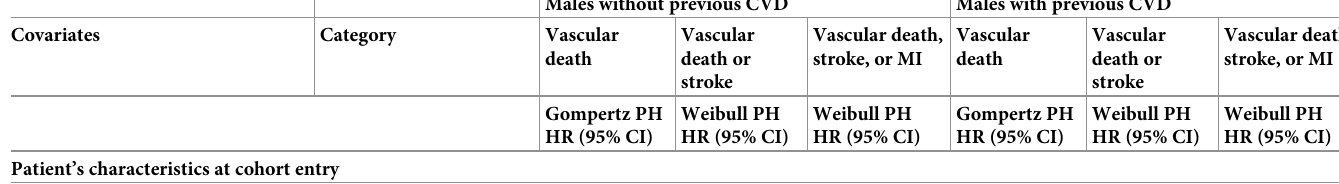
Table 2. Risk equations for CVD endpoints in the CKD–CVD policy model